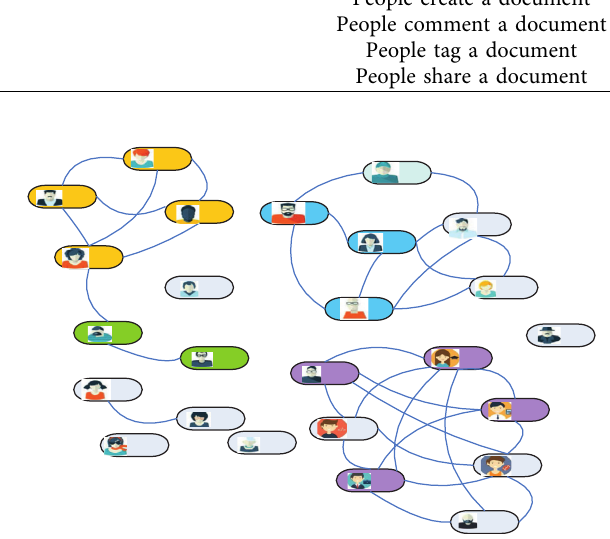
Figure 7: Social graph visualization of social